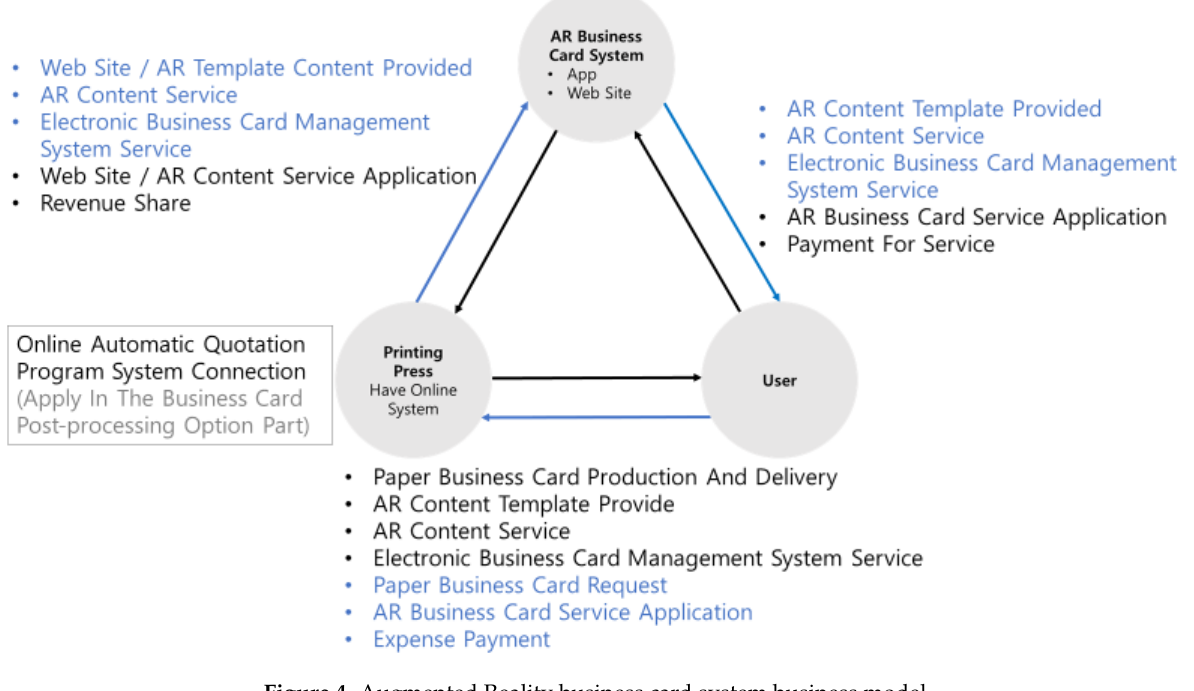
Figure 4. Augmented Reality business card system business model.